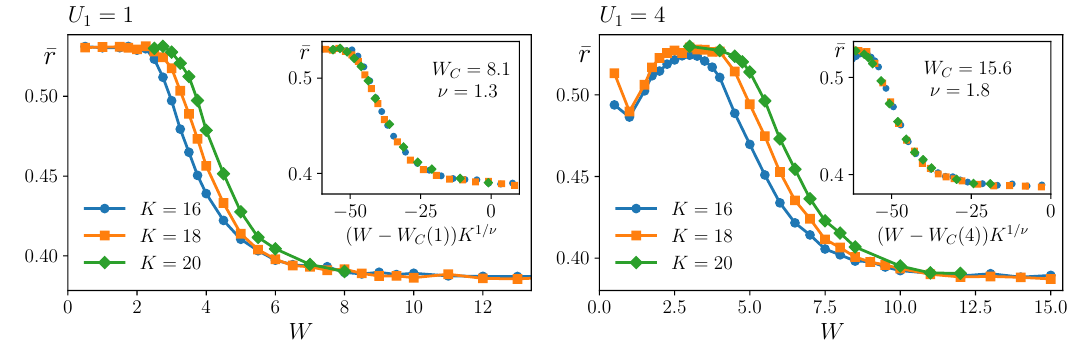
Figure 3: Onset: The mean gap ratio r , in the center of the spectrum, is displayed as a function of the disorder amplitude W and for K = 16,18,20 lattice sites. The = 1 , the right one to U = 4. The insets display the left panel corresponds to U 1 1 data rescaled according to Eq. (8). Error bars are smaller than the marker’s size. [( W − W ( U )) K 1 /ν ] are modeled by third order polyno- The universal functions g U 1 C 1 mials, points with r ∈ [ 0.392,0.48 ] are taken into account in the finite-size scaling